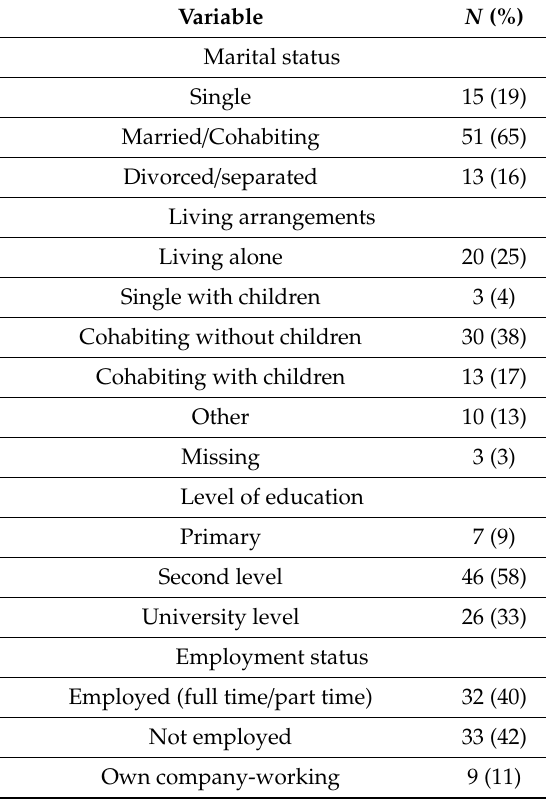
Table 5. Socio-demographic data among 79 heart recipients one to five years after heart